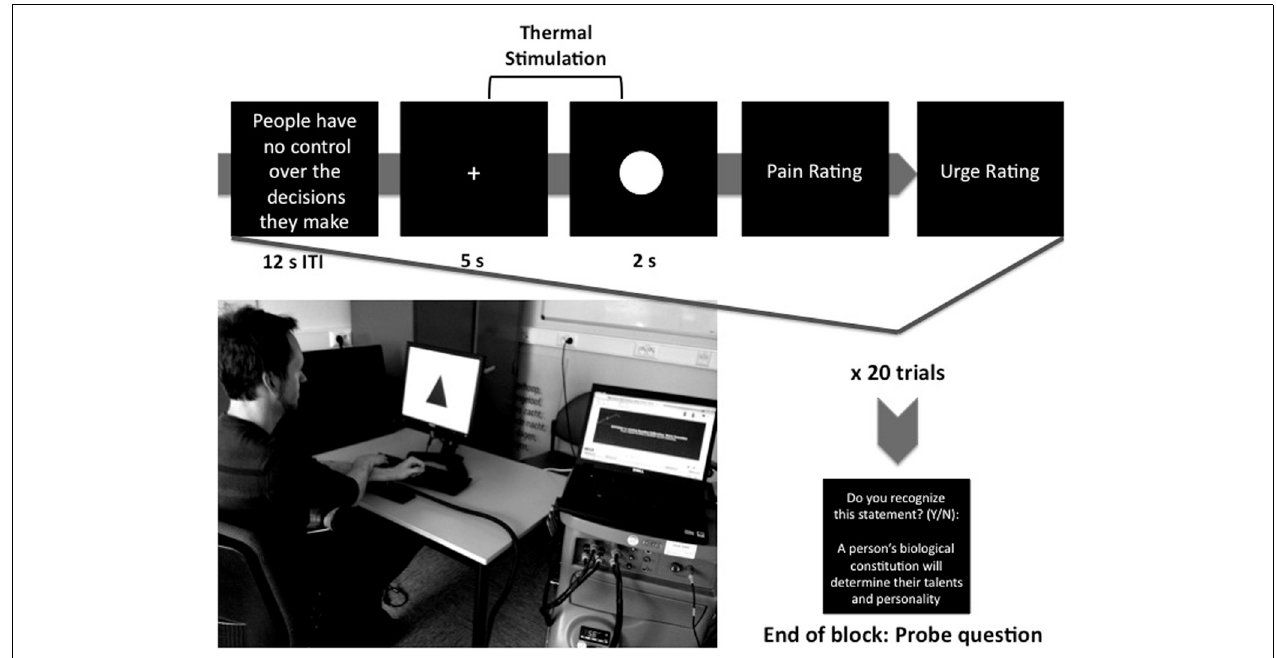
FIGURE 1 | Schematic overview of a sample block (Anti-free will condition). Note that there was no time limit for pain and urge rating responses.